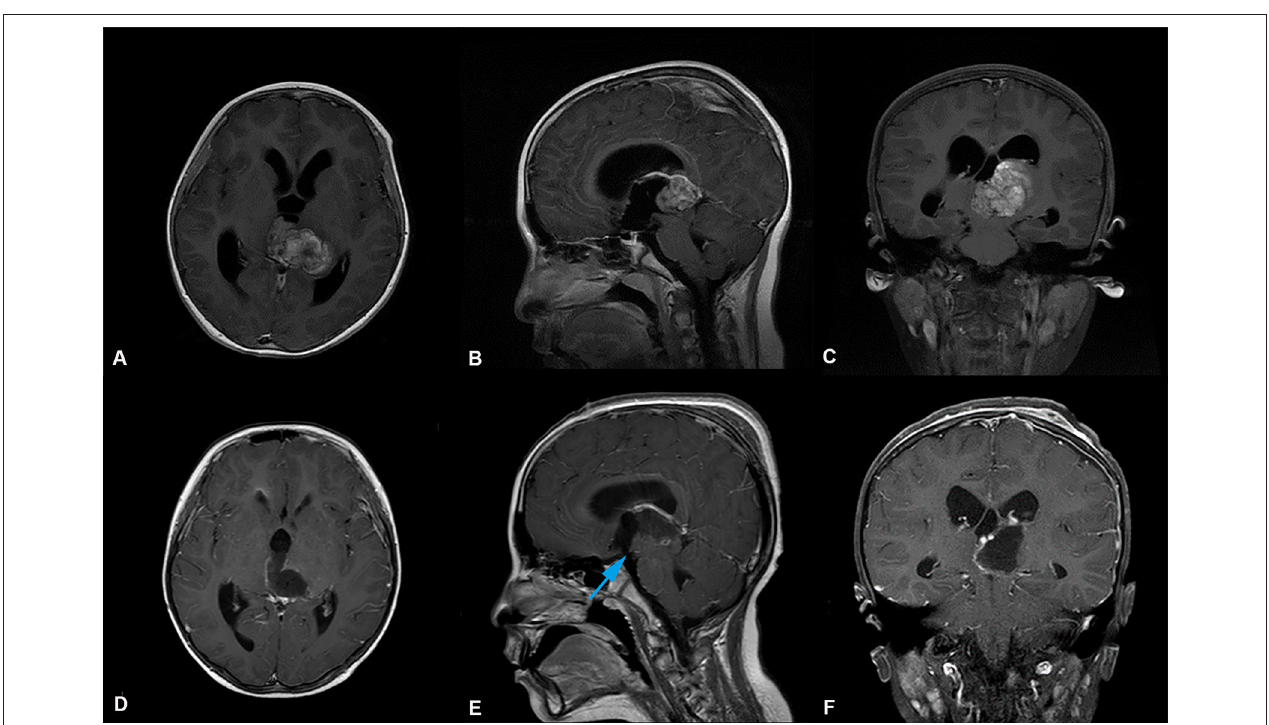
FIGURE 2 | Preoperative and postoperative imaging of thalamic malignant tumor resection with left trans-frontal lateral ventricle approach + third ventriculostomy. (A-C) display: Axial, sagittal and coronal enhanced MRI of malignant tumors of the left thalamus. MRI shows that the main body of the tumor was located in the left thalamus, invading the third ventricle, the right thalamus, the supratentorial lateral ventricle, and the expansion of the third ventricle. (D-F) display: MRI of thalamic tumor resection with left trans-frontal lateral ventricle approach + third ventriculostomy. The images show that the tumor was completely removed, and the volume of the lateral ventricle did not increase and expand. The position indicated by the blue arrow ( ) in e is the leak at the bottom of the third